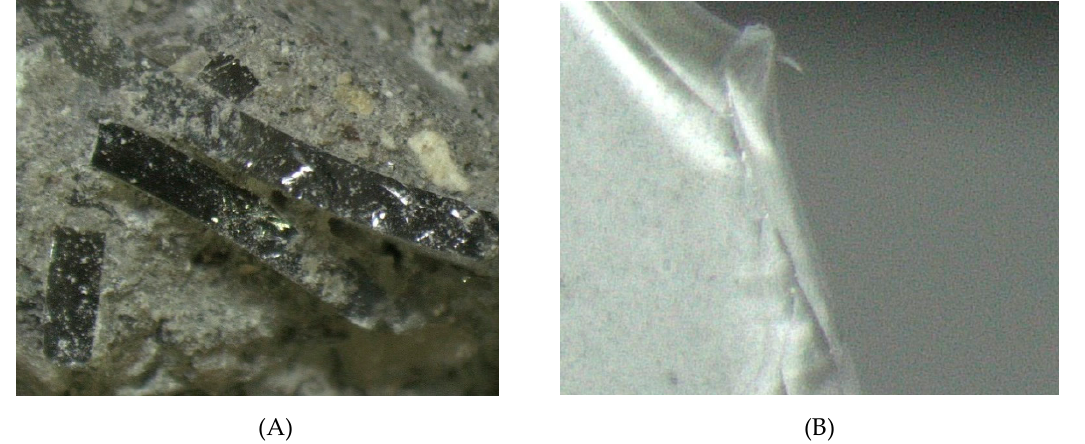
Figure 5. Enlarged glass aggregate grain ( A ) in the leaven, and ( B ) in proximity to the surface 321 structure. 322